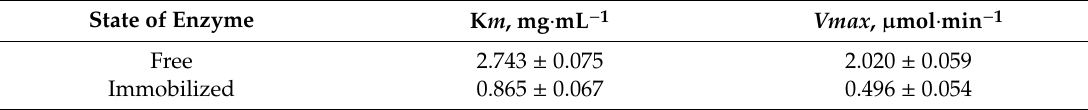
Table 4. Kinetic parameters of free and immobilized amyloglucosidase. State of